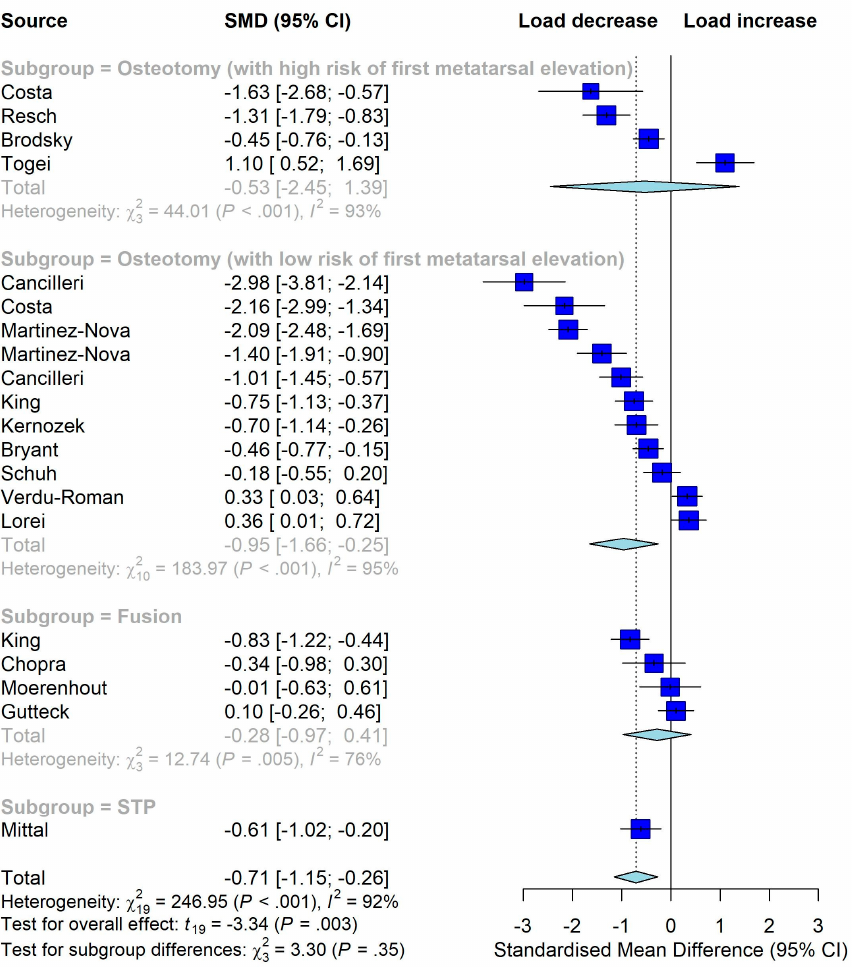
Figure 3. Meta-analysis on the overall effects of surgeries on plantar load over hallux region (increase means better). STP: soft tissue procedure [24,25,32,33,33–36,38,41–44,46,49,50,53,54,54].